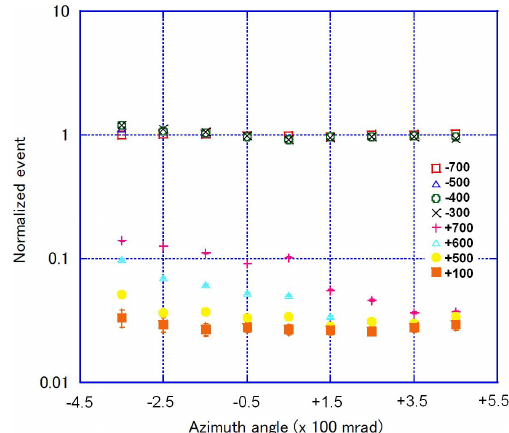
Fig. 3. Azimuth distributions at different elevations ( θ = − 700, − 500, − 400, − 300, + 700, + 600, + 500, and + 100mrad) normal- ized to the reference azimuth distribution ( θ = −